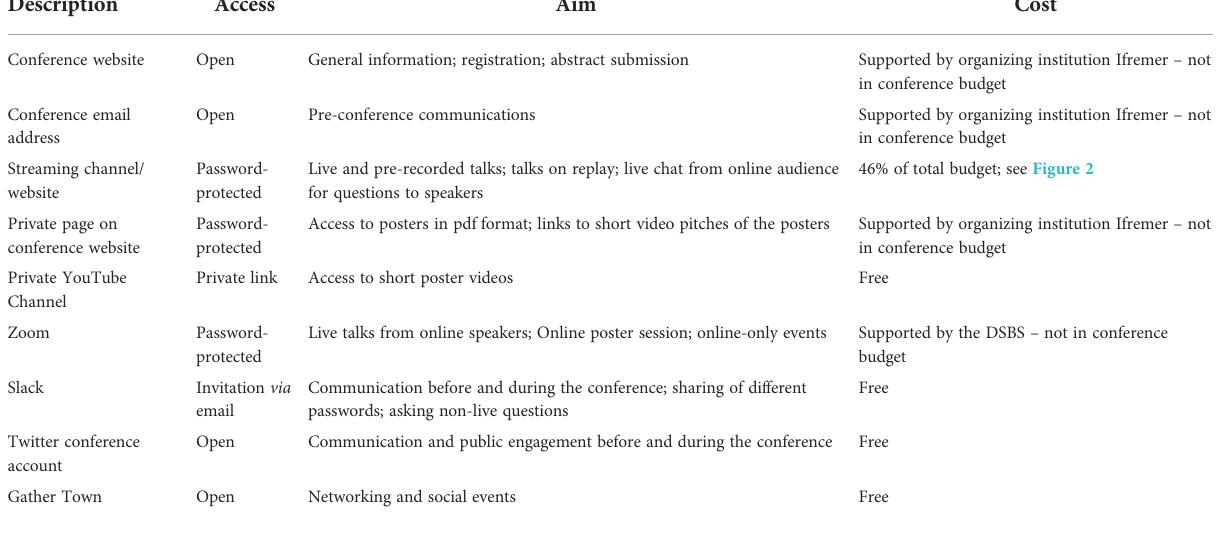
TABLE 1 Summary of online platforms used for 16DSBS and their